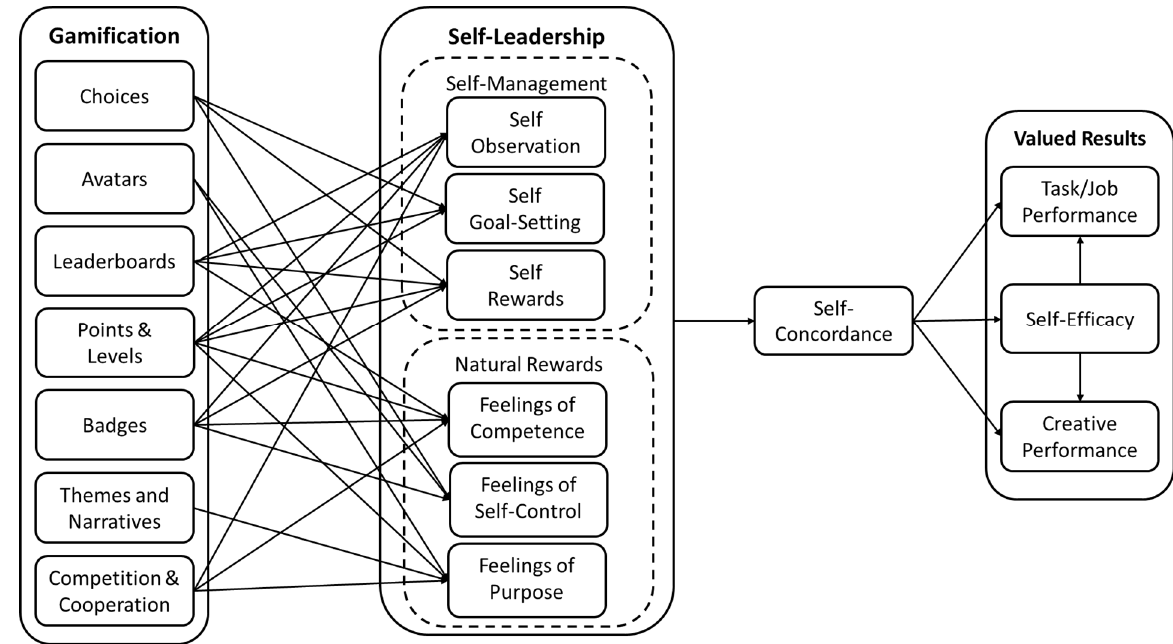
Figure 1. A conceptual framework for understanding the relationships between gamification elements and self-concordance, as mediated by self-leadership and how these can lead to valued individual outcomes.